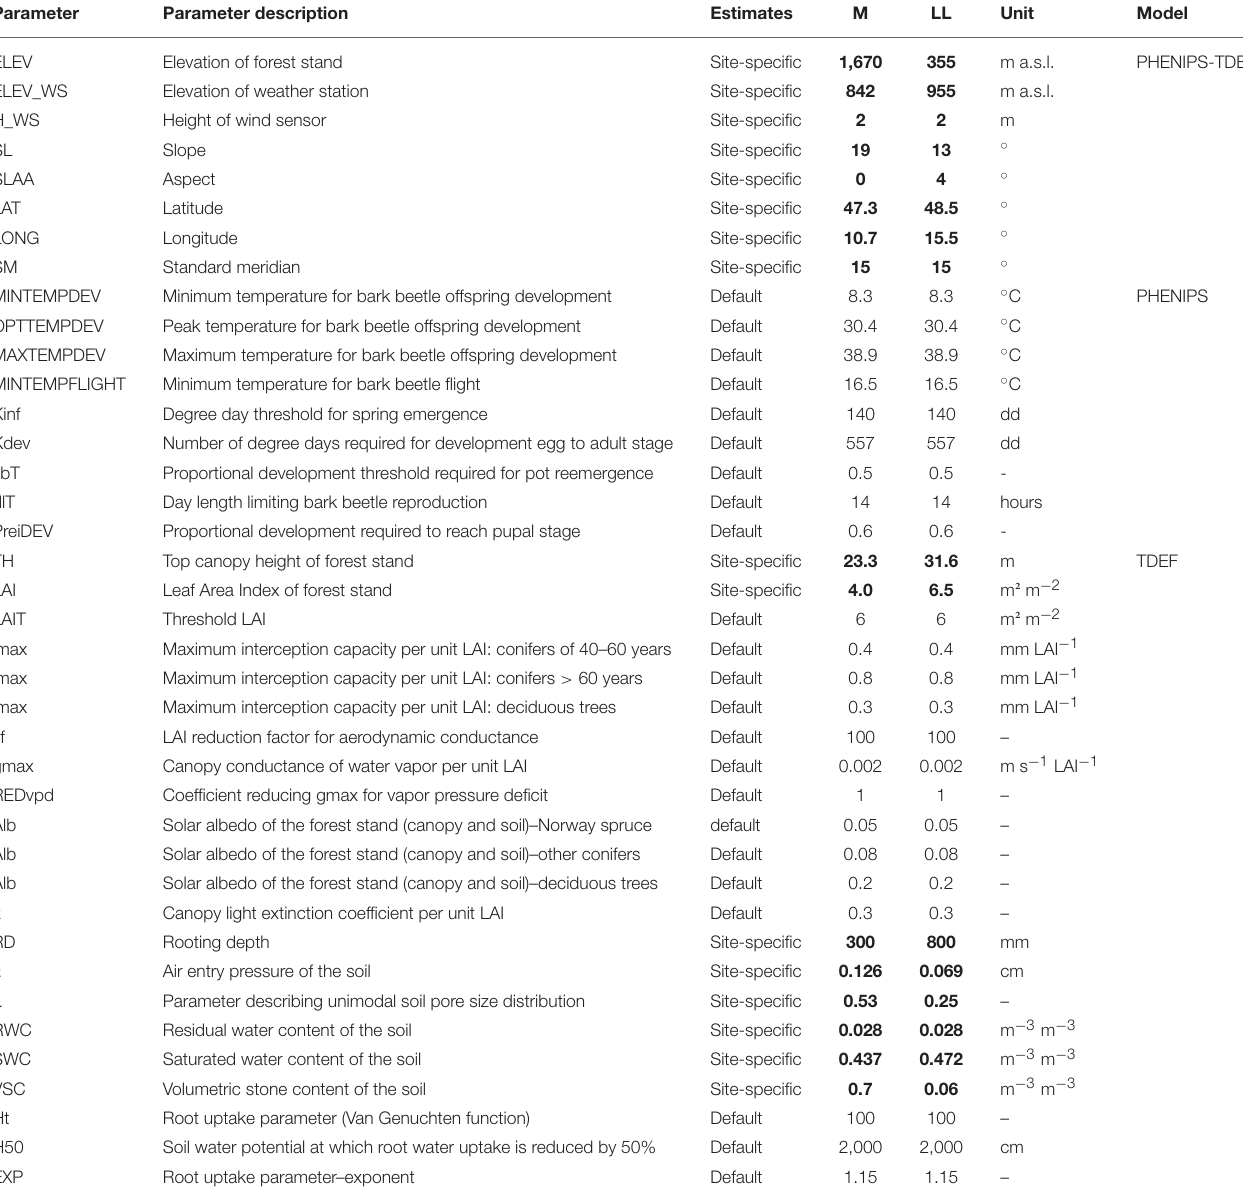
TABLE 3 | Default and site specific (bold) input parameters for PHENIPS-TDEF simulations according to the overview of Matthews et al. (2018).